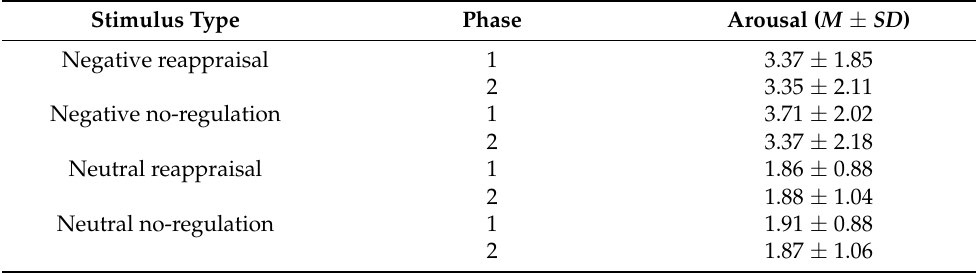
Table 1. Descriptive Statistics for Behavioral Ratings.